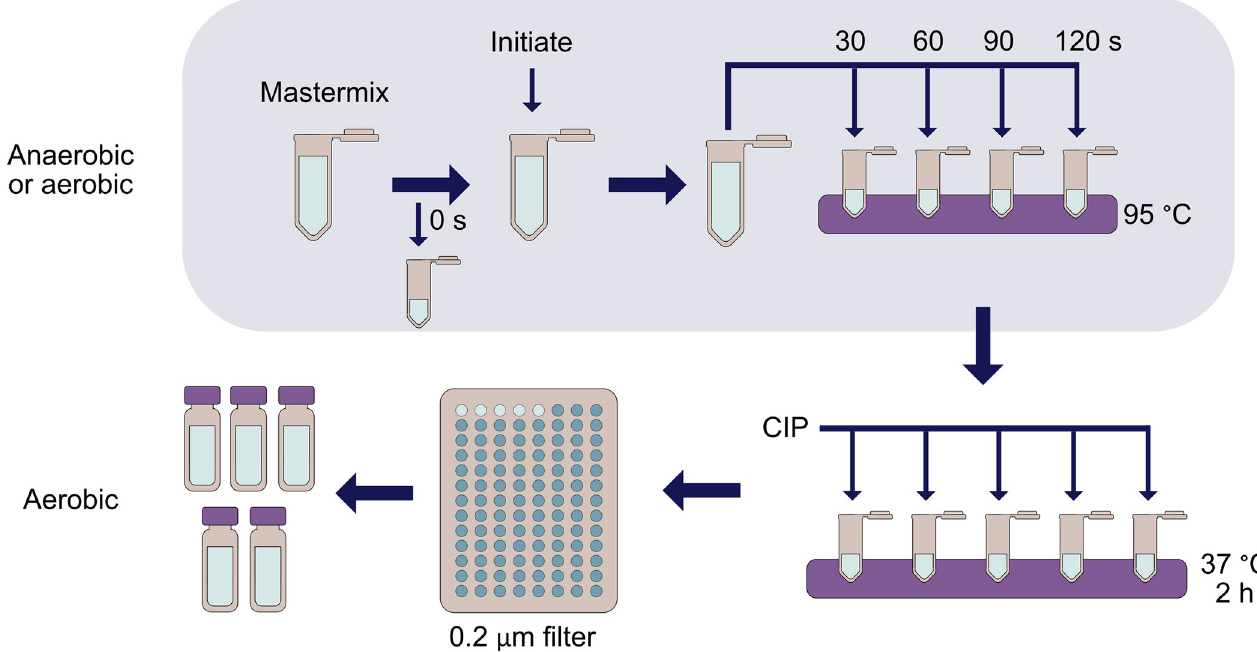
Fig 2. Overall scheme of LC-MS/MS RNR activity assay. Either aerobically or anaerobically, a mastermix is created and a zero point is taken prior to initiation with beta (aerobic assays) or nucleotides (anaerobic assays). The reaction is allowed to proceed for 120 s with time points taken every 30 s. Inactivation of the reaction occurs by heating the sample to 95˚C in a thermocycler or heat block. After inactivation, anaerobic assays are removed from the box and all assays have 1 μ L of calf intestinal phosphatase (CIP) added to dephosphorylate the nucleotides at 37˚C for 2 hours. The samples are then filtered through a 0.2 μ m filter and transferred to mass spectrometry vials for analysis via LC-MS/MS.